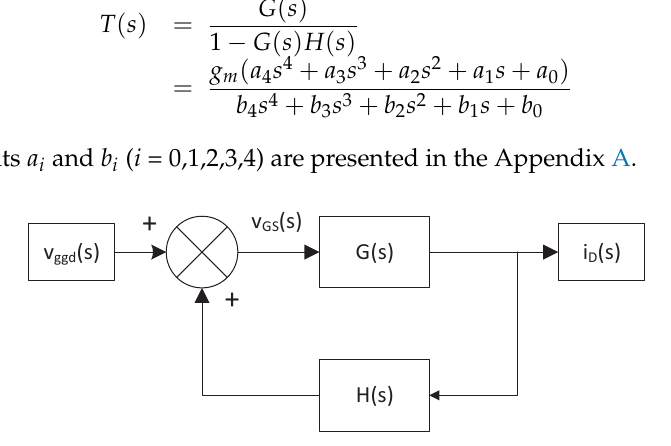
Figure 10. The positive feedback block